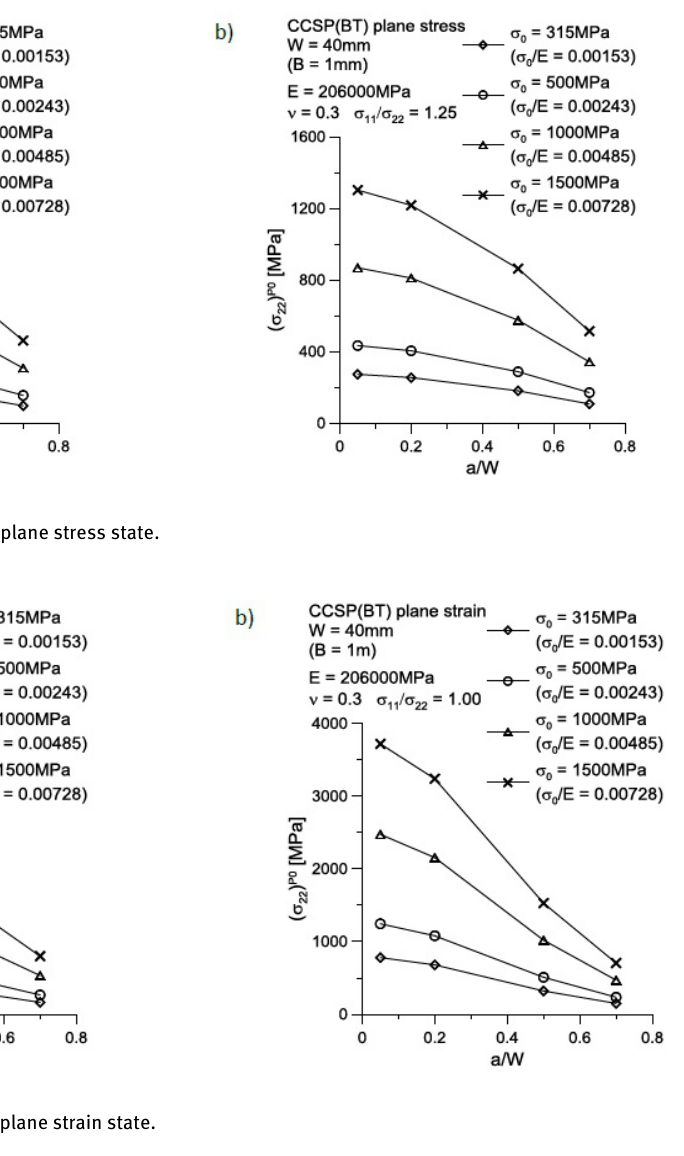
( σ 22 ) P 0 and the crack length was nonlinear. The greater the yield strength, the stronger the nonlinearity of the re- lationships between ( σ 22 ) P 0 and a / W